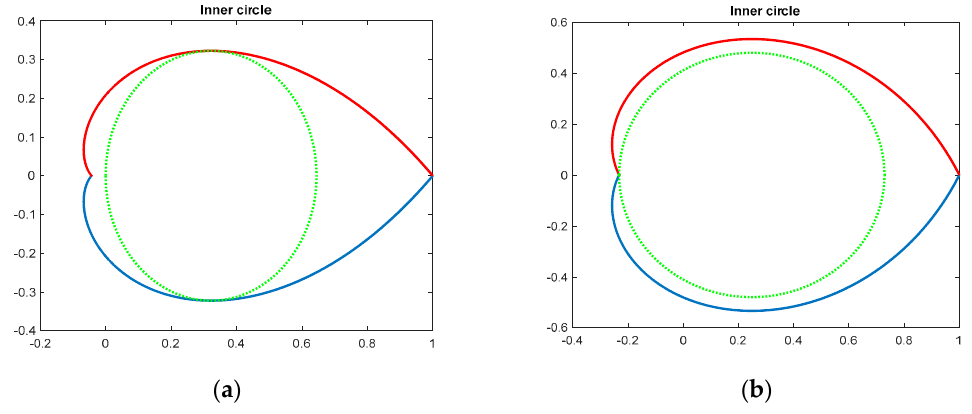
Figure 6. Inner circle approximation of cardioid: ( a ) For a 45 ◦ damping angle and ( b ) for a 65 ◦